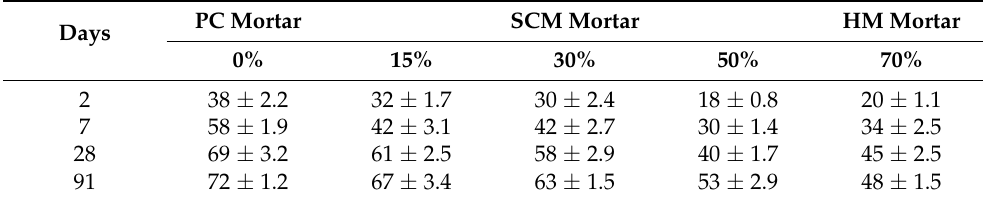
Table 8. Compressive strength of MFS slag mortars in MPa (in function of wt% of MFS slag vs. total binder). HM: Hybrid